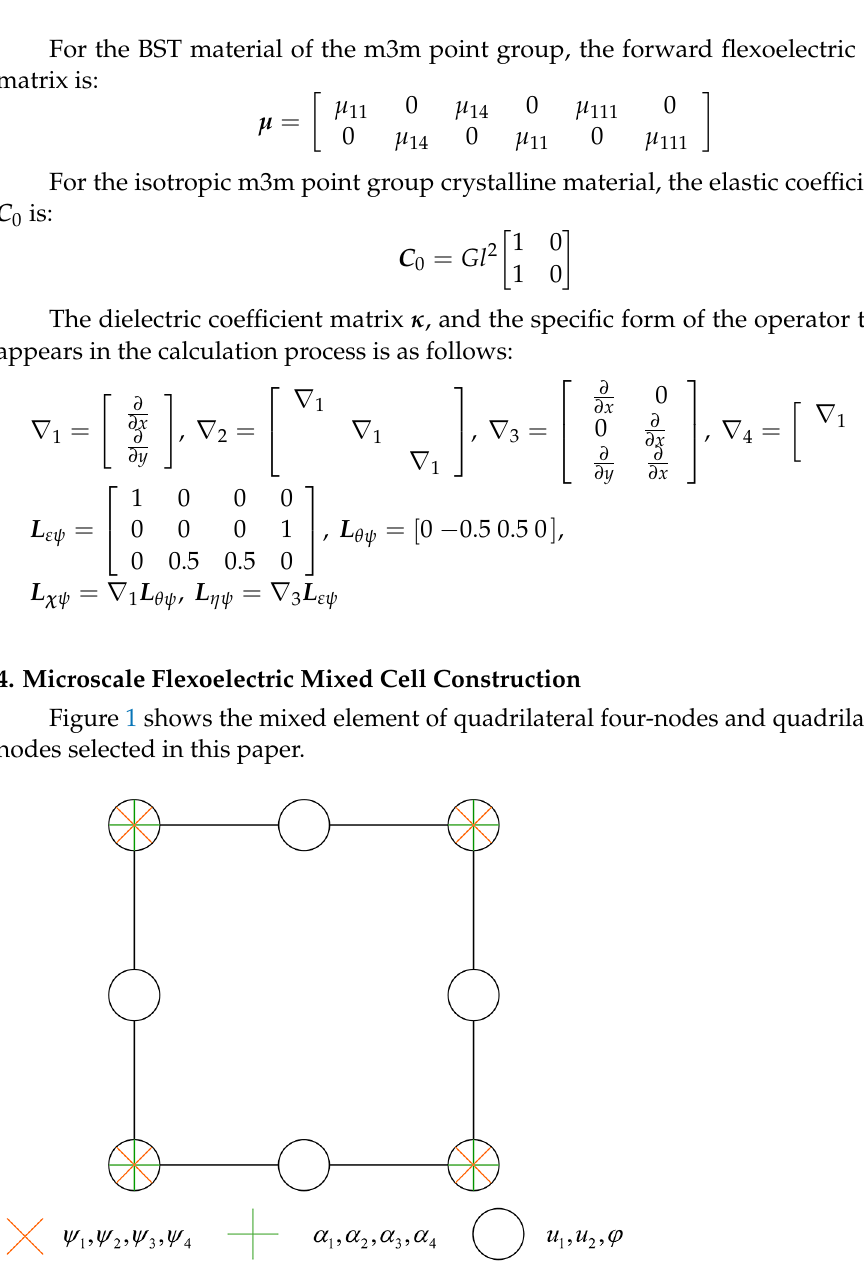
Figure 1. Two dimensional 8(4) Nodes fl exoelectric mixed element.